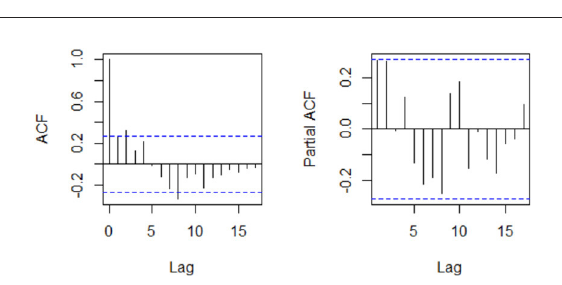
FIGURE4 Plot of the autocorrelation and partial autocorrelation functions of the weekly COVID-19